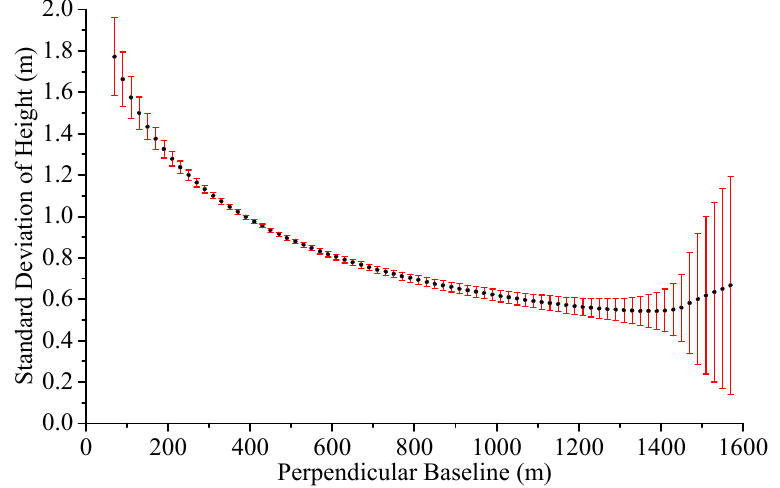
Figure 13. Mean and standard deviation of height measurement error at di ff erent terrain slope under the same perpendicular baseline.